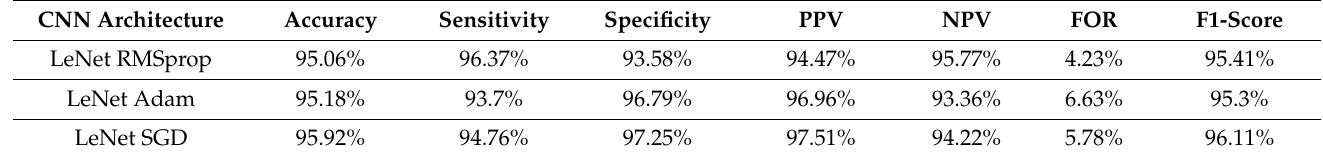
Table 3. Validation statistical analysis of the LeNet model.